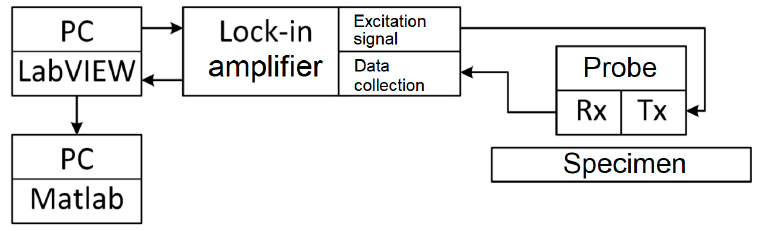
Figure 1. Data acquisition and signal processing devices during the SFECT measurements.